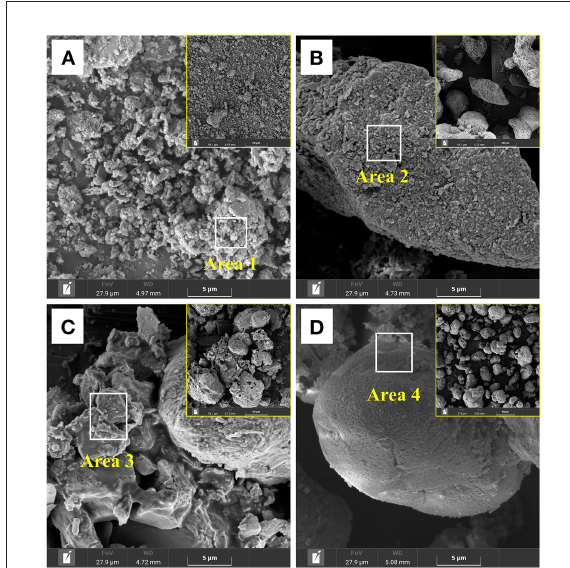
FIGURE3 SEM images of solid residues after bioleaching of metals from RM by Sb. thermosulfidooxidans . Bioleaching was conducted for 27 days in shake flasks with the S 0 /RM mass ratio of (A) 0:1, (B) 1:1, (C) 2:1, and (D) 3:1. Areas 1, 2, 3, and 4 are the EDS analysis